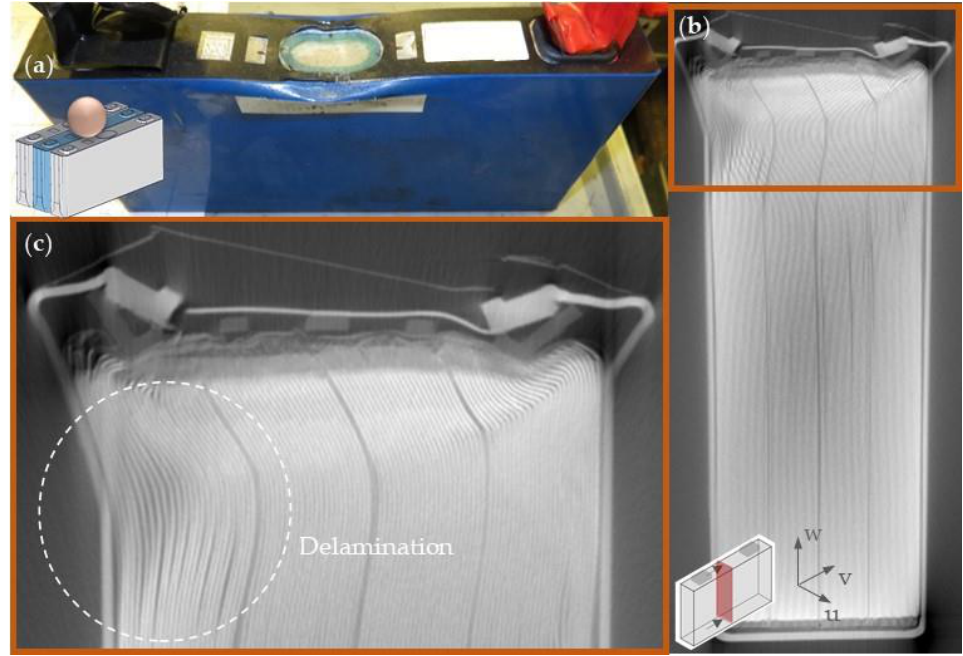
Figure 17. W-direction with hemispherical impactor: ( a ) deformed middle cell; ( b , c )